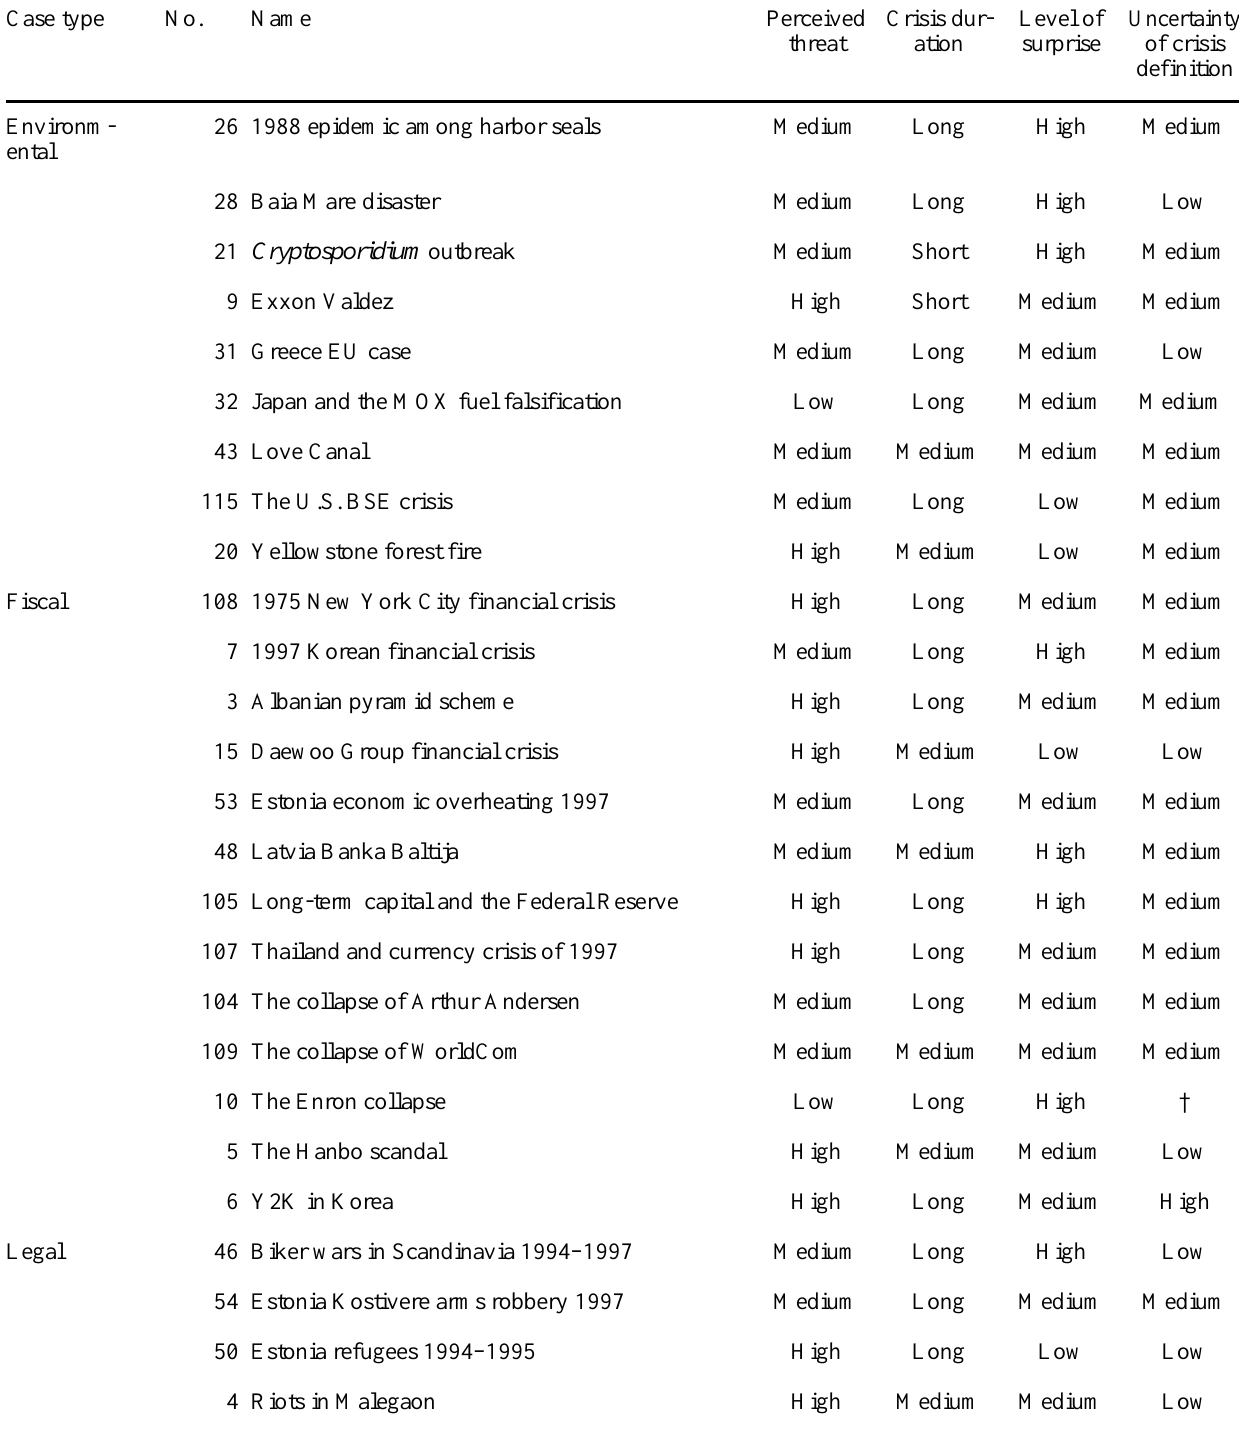
Table 1. List of cases from the Transboundary Crisis Management Data Bank. Case